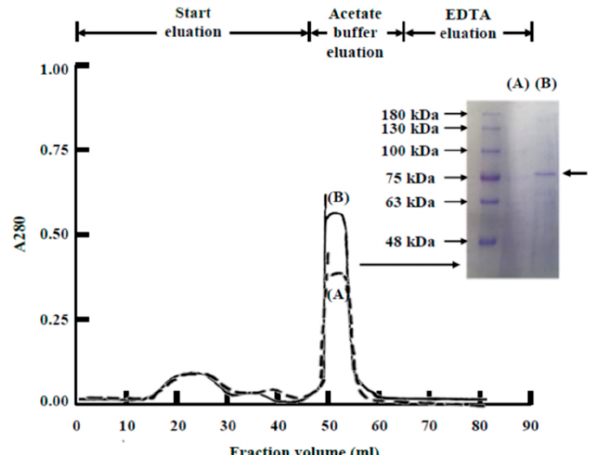
Figure 3. Isolation and identification of zinc-binding protein from the blood cells of ZnSO 4 -injected PHZ-induced anemic rats. Rat blood cells were collected from ( A ) normal rats; and ( B ) 2.8 mg Zn/kg body weight ZnSO 4 -injected PHZ-induced anemic rats. The cells collected were extracted using a detergent buffer, and the detergent extract was purified by Zn 2+ -IMAC. The acetate buffer eluates were pooled and analyzed by SDS-PAGE under reducing conditions, followed by staining with Coomassie blue to visualize the protein bands. The major difference between normal rats ( A ) and zinc-injected anemic rats ( B ) was the band with a molecular weight of 76 kDa in ( B ). The arrowhead denotes the position of the protein identi fi ed by nano-LC-MS/MS analysis as rat serum transferrin. 2.3. Zinc Salts Stimulated Erythropoiesis in Rat Bone Marrow Cells In Vitro